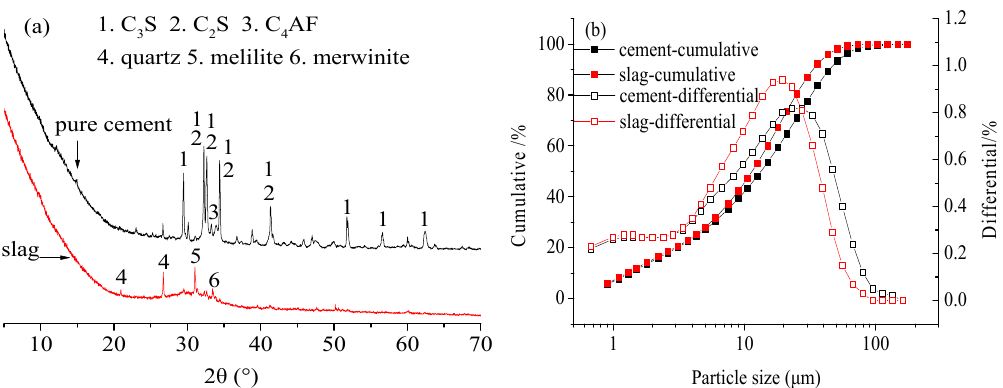
Figure 1. Mineral compositions and particle size distributions of cement and slag powder: ( a ) mineral compositions, ( b ) particle size distribution.